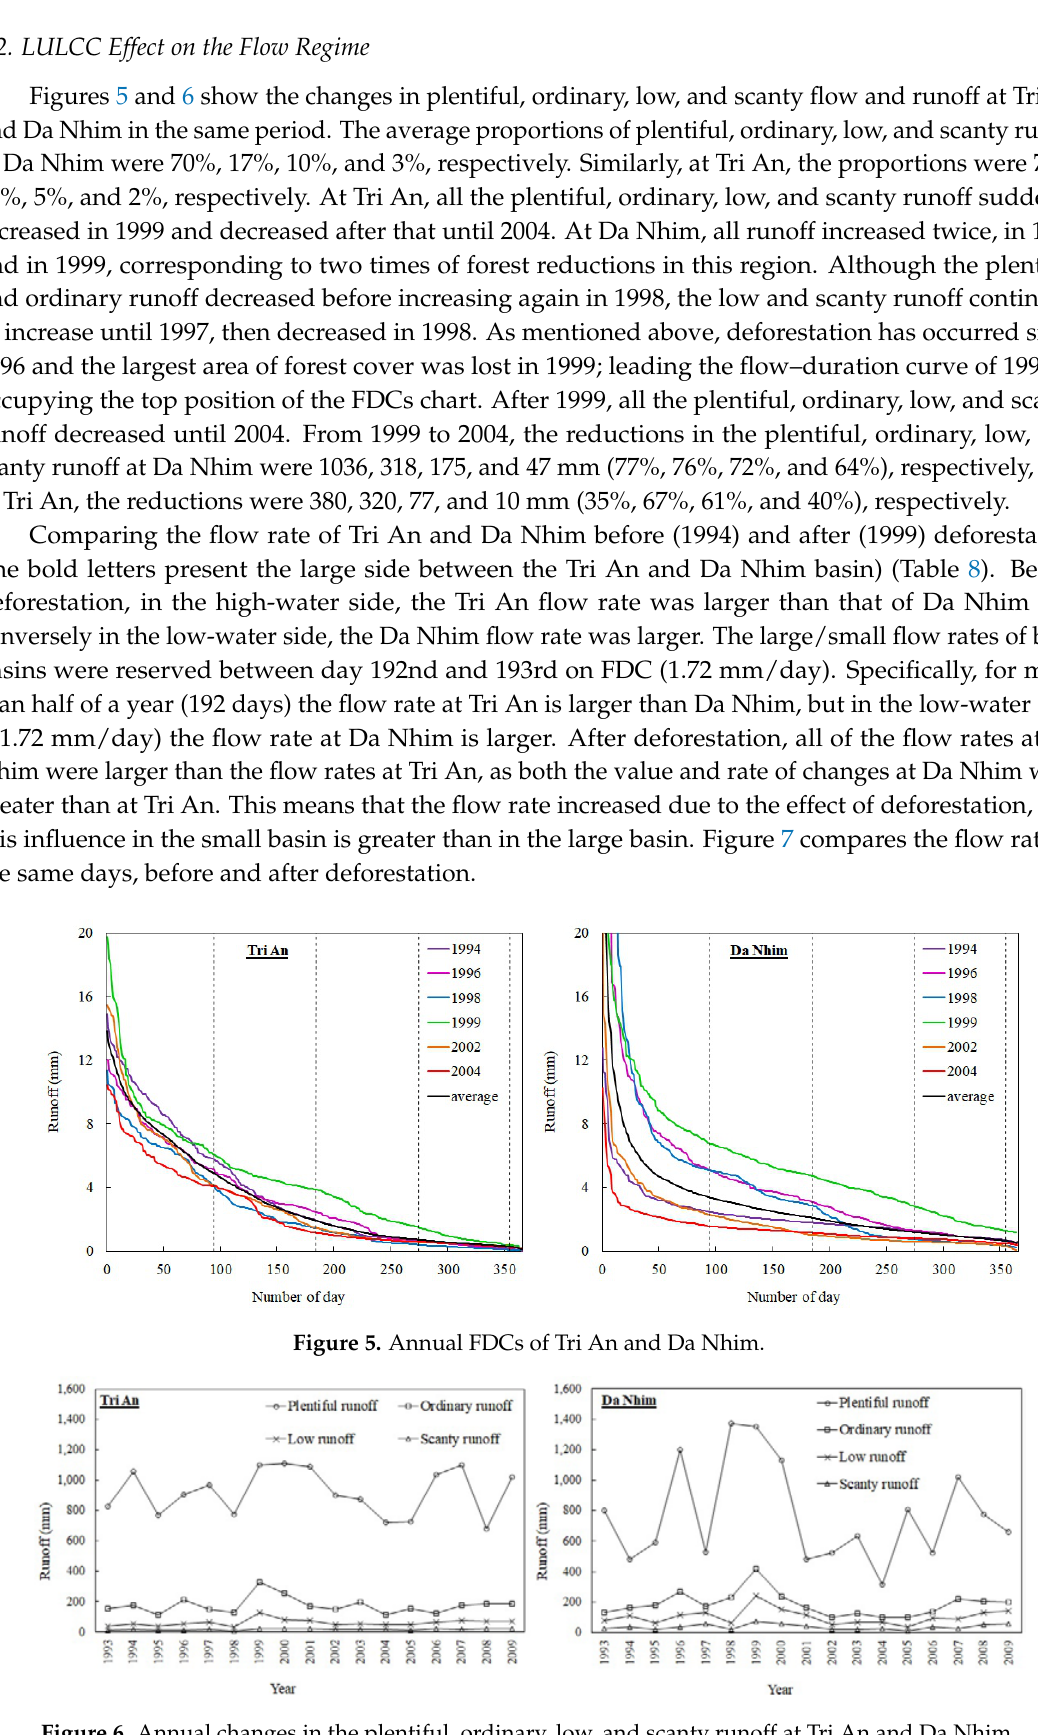
Figure 6. Annual changes in the plentiful, ordinary, low, and scanty runoff at Tri An and Da Nhim.